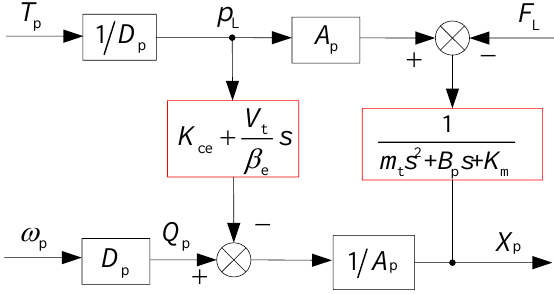
Figure 9. System pressure flow coupling block diagram.